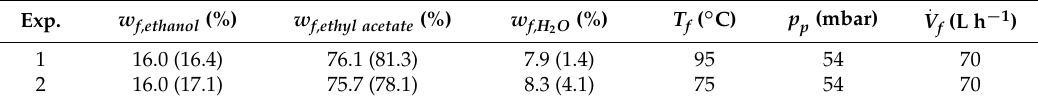
Table 4. Overview of process parameters used in the ternary experiments. The mass fractions are given for the start of the experiments and in brackets after 10 h. The mass fractions listed are the mean value based on the thrice-repeated experiments. All experiments were conducted with a feed pressure of 5 bar.